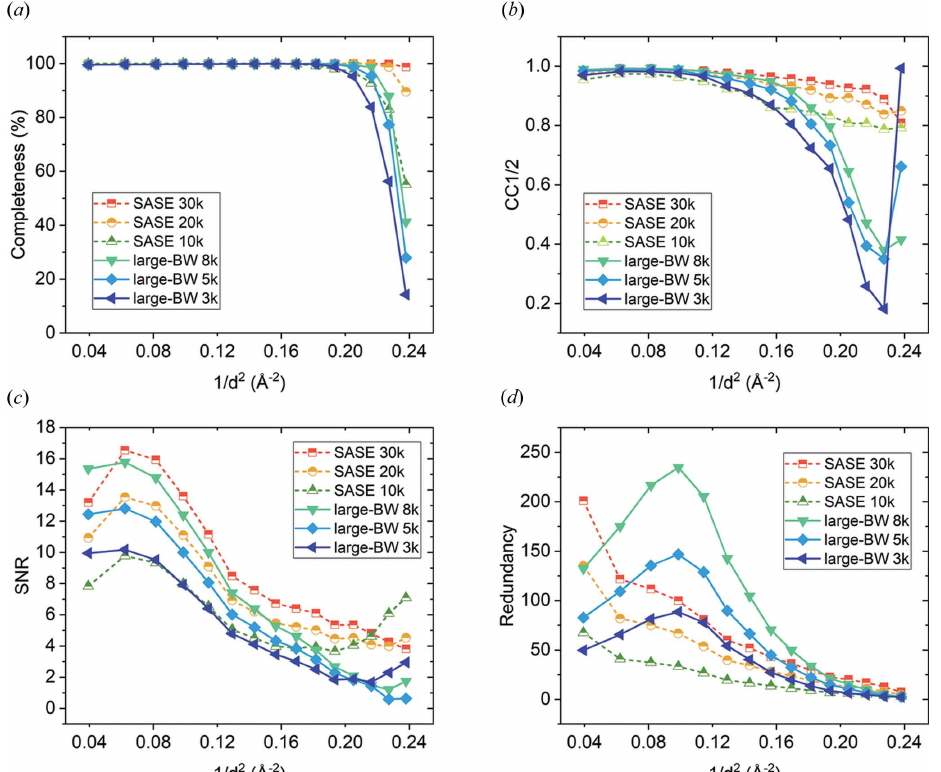
Figure 3 Comparison of data-quality indicators between the SASE and large-BW thaumatin data sets with various number of indexed images calculated up to a resolution limit of 2.05 A˚ . ( a ) Completeness, ( b ) CC 1/2 , ( c ) SNR and ( d ) redundancy of individual reflections as a function of